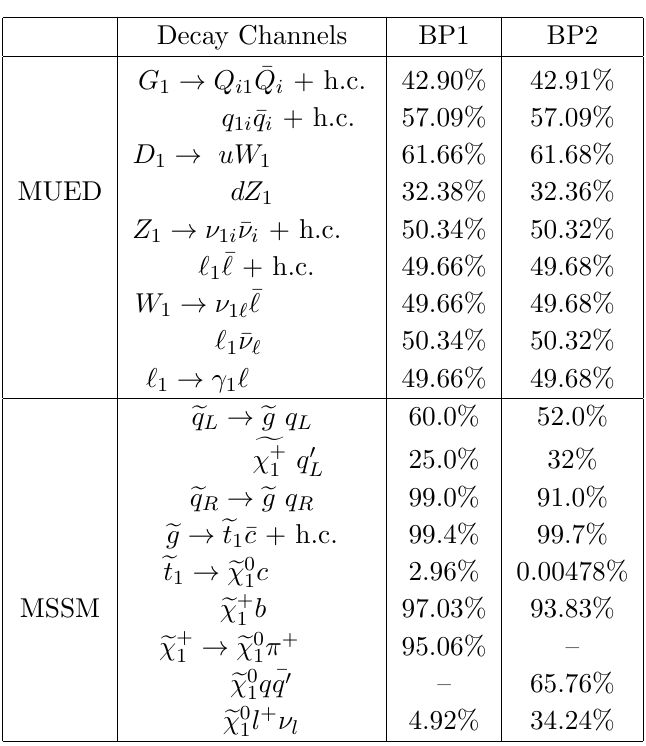
Table 2 . Some important branching ratios for MUED and MSSM benchmark